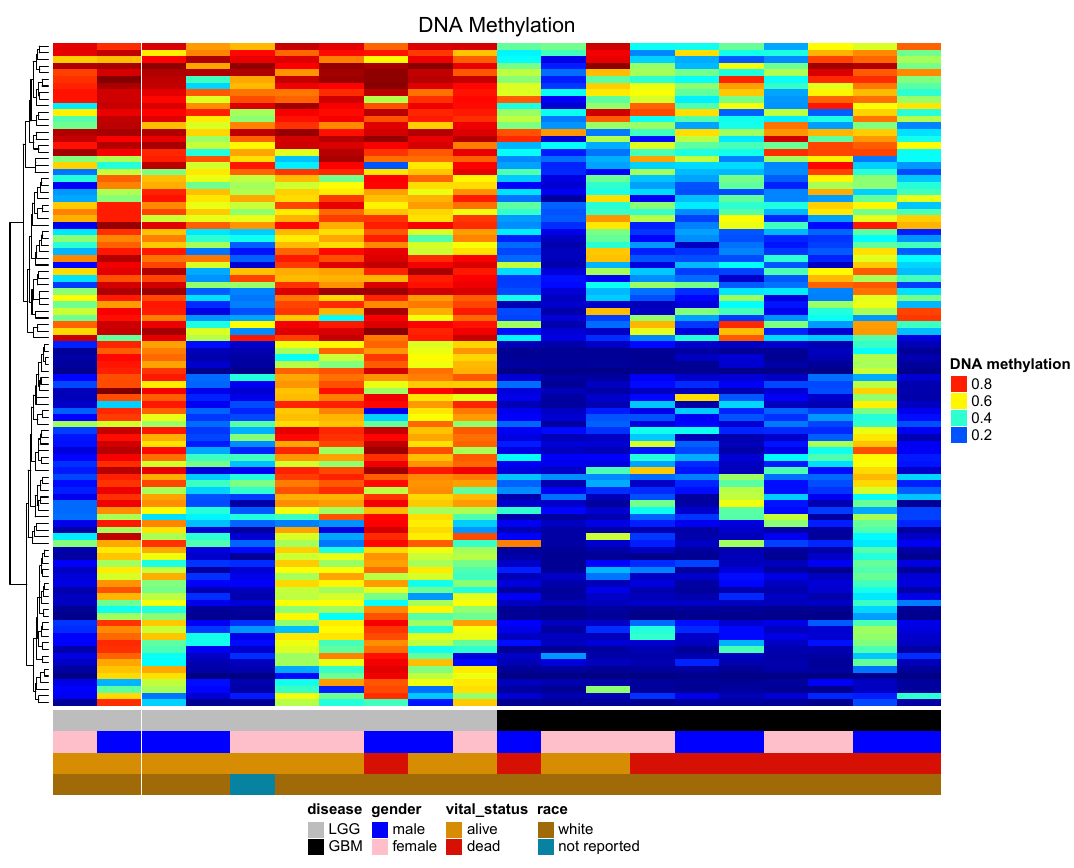
Figure 10. Heatmap of DNA methylation in probes. Rows are probes and columns are samples (patients). The DNA methylation values range from 0.0 (completely DNA unmethylated, blue) to 1.0 (completely DNA methylated, red). The groups of each sample were annotated in the top bar and the DNA methylation status for each probe was annotated in the right bar.